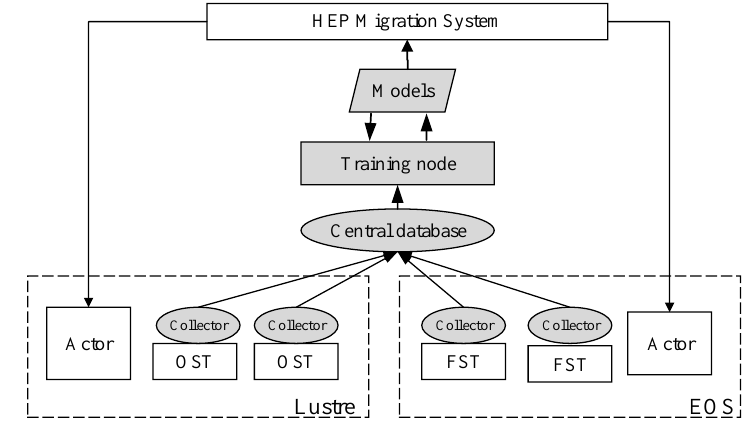
Figure 2 High-energy physical data heat prediction and migration